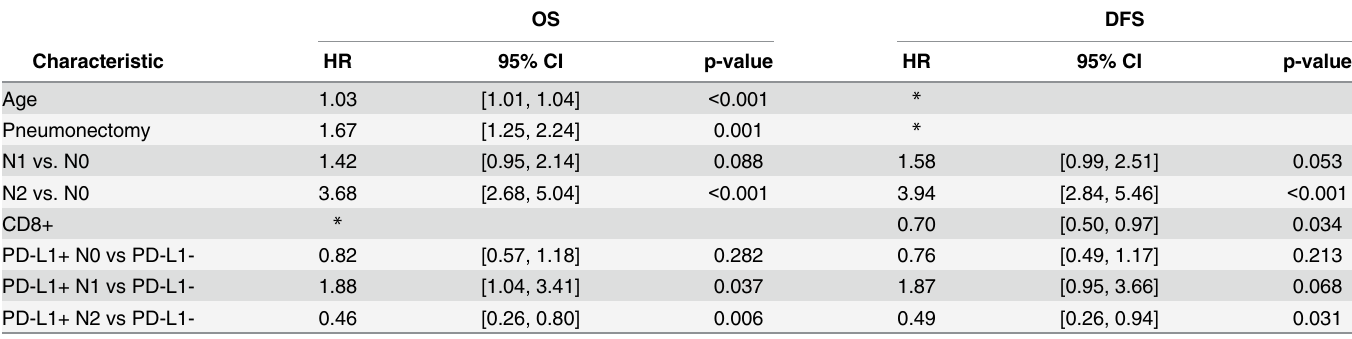
Table 2. Multivariate analysis for OS,